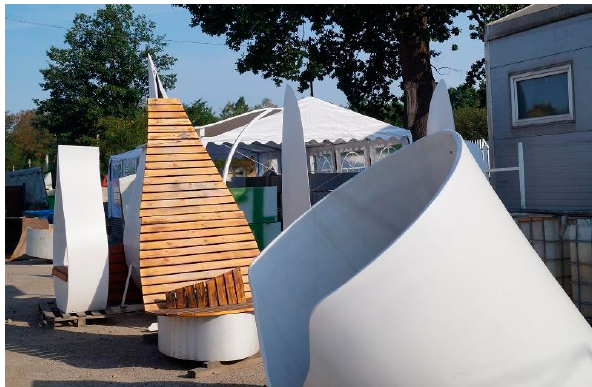
Figure A9. Blade-made load-bearing structural supports for pedestrian bridges [49].